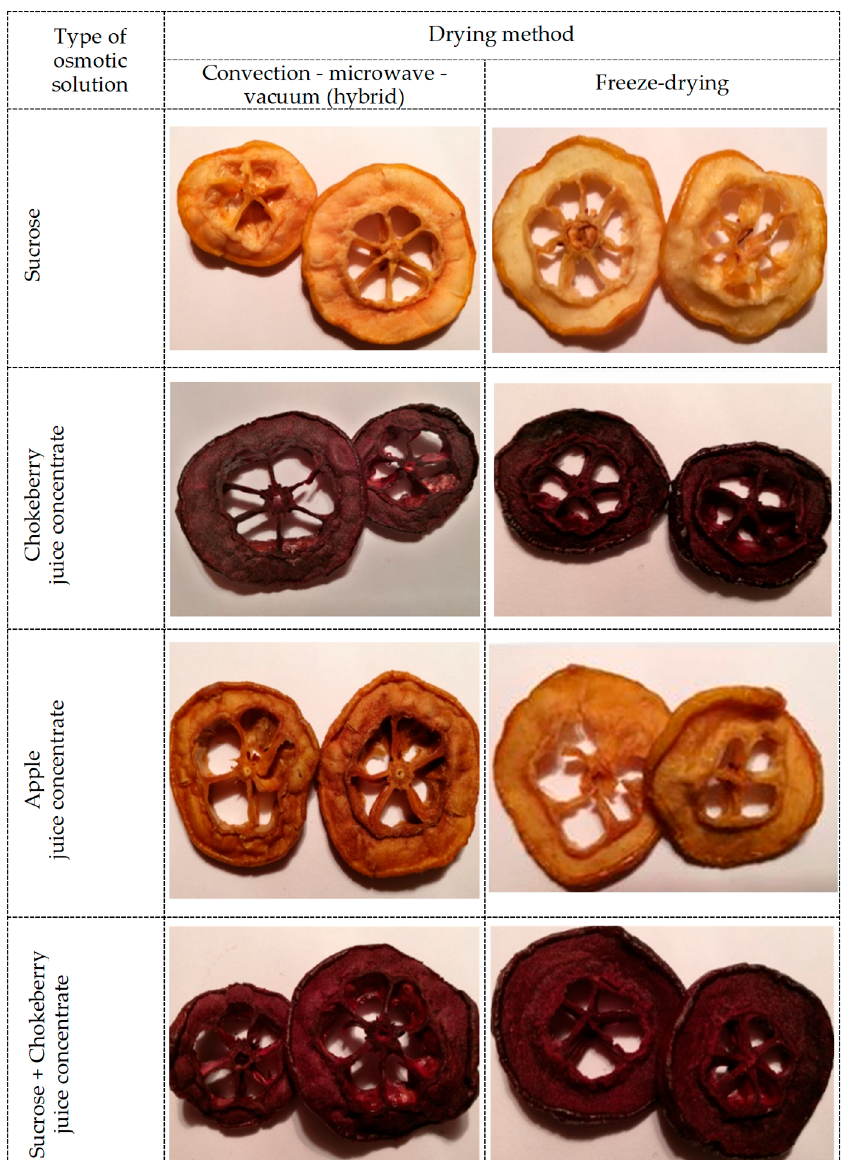
Figure A1. Pictures of Japanese quince chips pre-osmotically dehydrated and dried; slices of maximum and minimum diameters, cut from fruit.